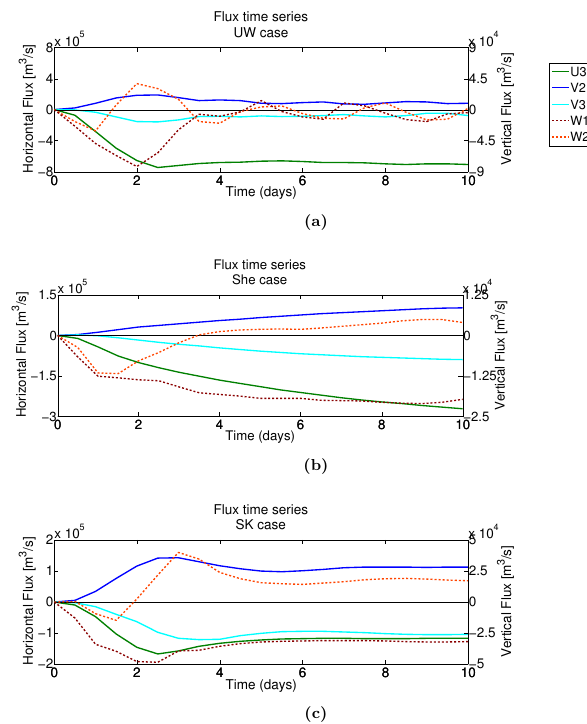
Figure 4. Time series of horizontal and vertical flux directly over the canyon for (a) core (UW), (b) surface-forced (She), and (c) slope-current (SK) simulations. U 3 indicates zonal flux across the canyon axis (from canyon head to canyon mouth). V 2 and V 3 are meridional flux along the canyon mouth from the upstream rim to canyon axis, and from the canyon axis to downstream rim, re- spectively. All horizontal fluxes are measured from surface to shelf break depth. W 2 and W 3 are vertical flux across the shelf break depth plane (150m) everywhere within the canyon, from the up- stream rim to canyon axis and from the canyon axis to downstream rim, respectively. Negative U , V , and W values indicate westward, offshore, and downwards